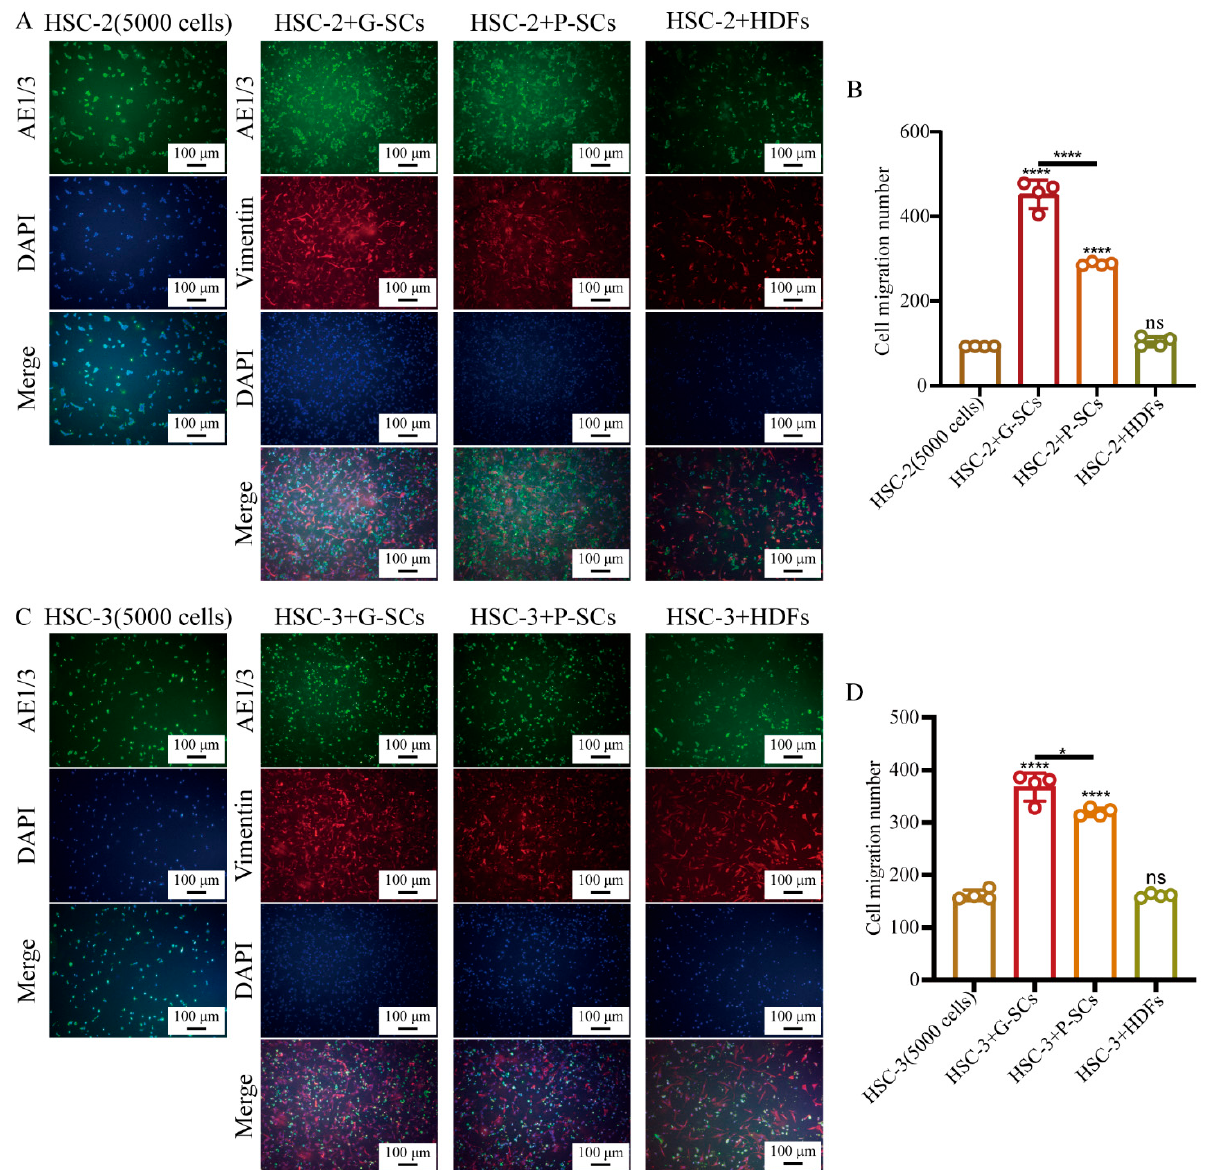
Figure 5. G-SCs and P-SCs promoted the migration of OSCC cells in vitro. ( A , C ) The effect of G-SCs and P-SCs on the migration of HSC-2 ( A ) and HSC-3 ( C ) was examined by transwell migration assay. ( B , D ) Quantification of cell migration in different groups of HSC-2 ( B ) and HSC-3 cells ( D ). Data are shown as the mean ± s.d. (s.d., standard deviation), n = 4. Each group compared with HSC-2 (5000 cells) and HSC-3 (5000 cells) group, and statistical analysis was performed by Student’s t -test, ns indicates p > 0.05, * indicates p < 0.05, **** indicates p < 0.0001.